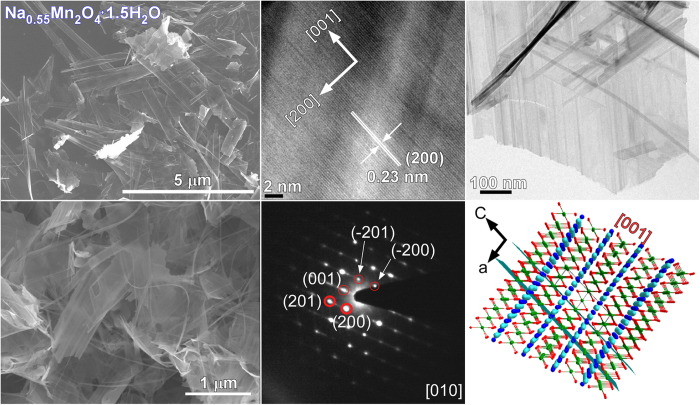
SEM (left column), low-magnification TEM, and HRTEM images of Na0.55Mn2O4·1.5H2O nanobelts.SAED and a model of the corresponding crystal planes are shown on the lower right.